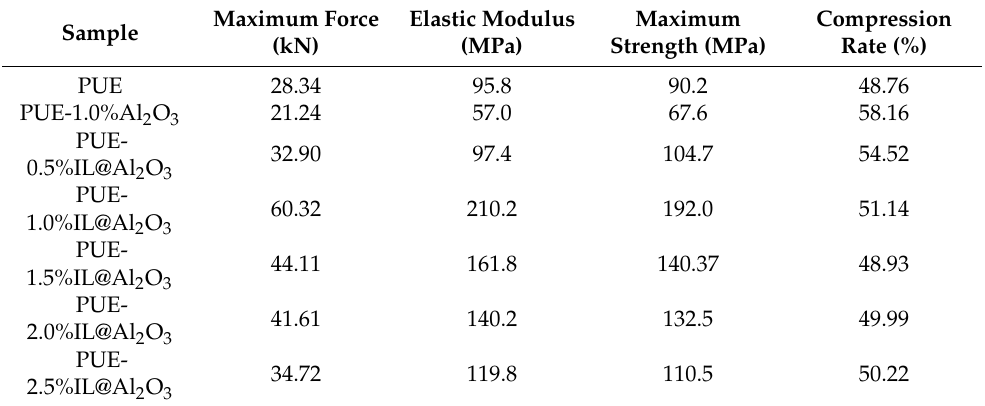
Figure 5. Quasi-static compression: ( a ) ER–ES curves of PUE-IL@Al 2 O 3 with proportions from 0.5% to 2.5%; ( b )ER–ES comparison curves; and ( c ) the compression deformation of PUE, PUE-1%Al 2 O 3 and PUE-1%IL@Al 2 O 3 specimens. Table 2. A data summary for PUE, PUE-Al 2 O 3 and PUE-IL@Al 2 O 3 under quasi-static compression